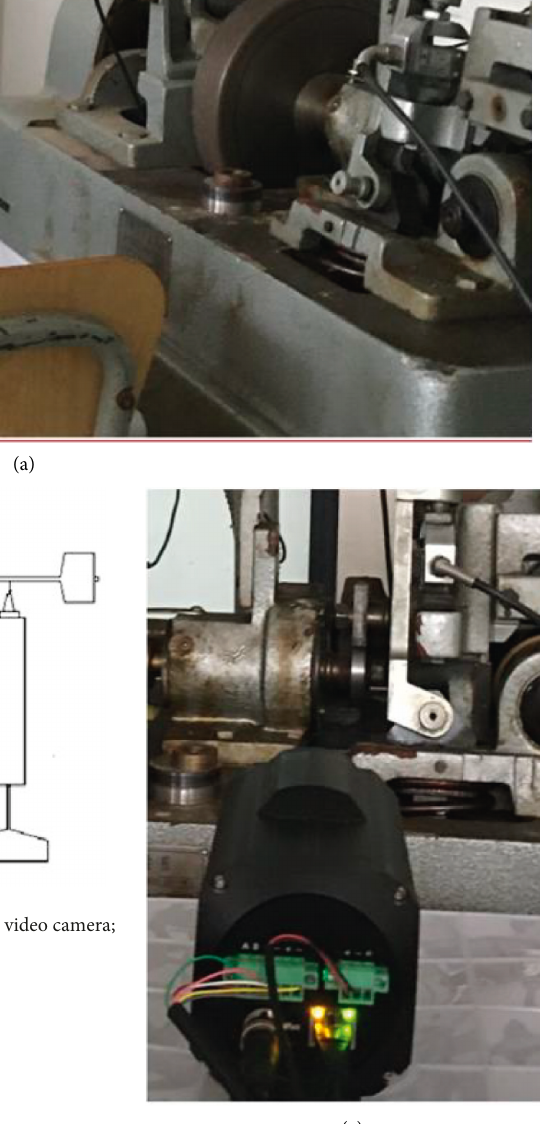
Figure 1: Experimental device schematic and photos of the experiment. (1) variable speed grinder; (2) sample; (3) pressure lever; (4) infrared video camera; (5) high-speed